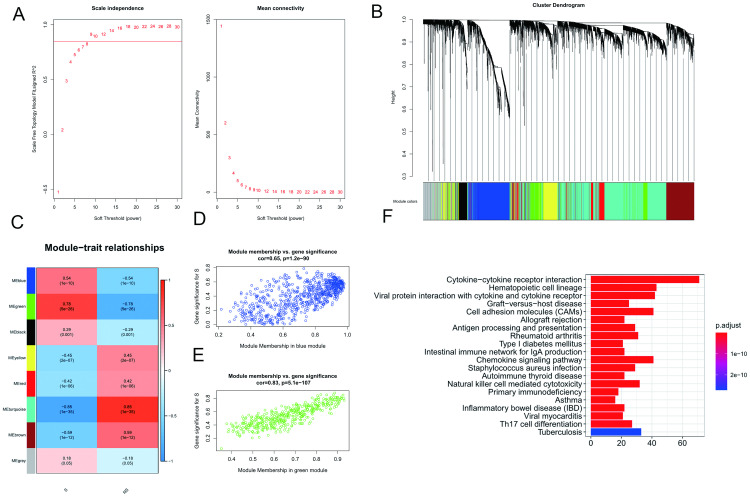
Identification of hub seminoma-correlated module.(A) Analysis of the scale-free fit index and mean connectivity for various soft-thresholding powers. (B) Cluster dendrogram of genes, with dissimilarity based on topological overlap. (C) Heatmap of the correlation between module eigengenes and clinical phenotypes. S, seminoma. NS, non-seminoma. Scatter plots of module eigengenes in the blue module (D) and green module (E). (F) Preliminary KEGG pathway enrichment analysis for genes in the blue module.